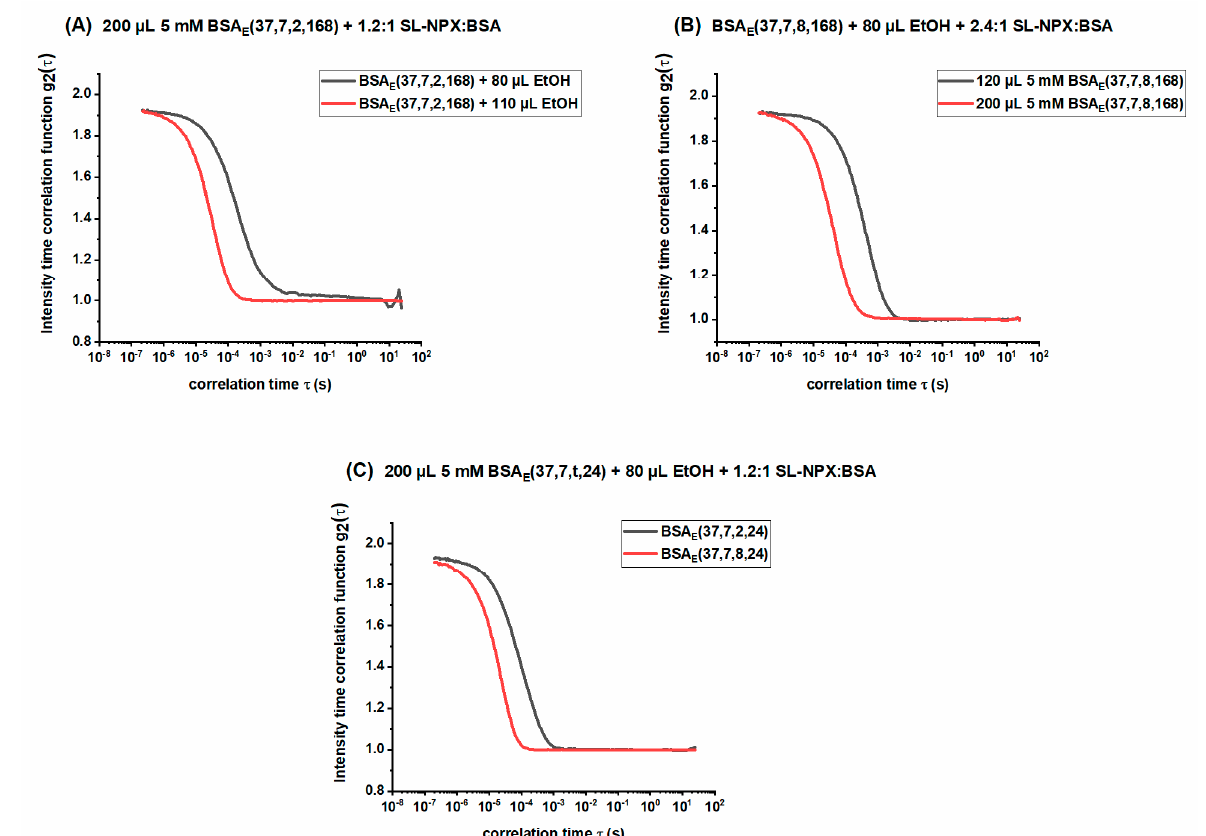
Figure 10. Intensity-time correlation functions for ( A ) SL-NPX-loaded BSA E (37, 7, 2, 168) at a 1.2:1 SL-NPX:BSA molar ratio prepared with different amounts of ethanol, ( B ) SL-NPX-loaded BSA E (37, 7, 8, 168) at a 2.4:1 SL-NPX:BSA molar ratio prepared with 80 µL ethanol and different BSA concentrations, and ( C ) SL-NPX-loaded BSA E (37, 7, t, 24) at a 1.2:1 SL-NPX:BSA molar ratio prepared with 80 µL ethanol.